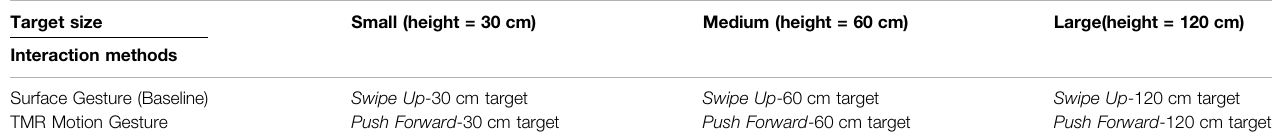
TABLE 3 | Conditions of surface gesture and TMR interaction technique validation.